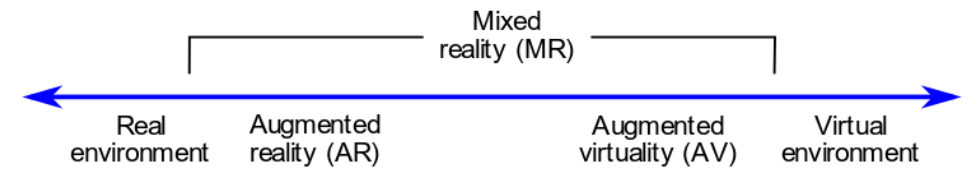
Figure 1. The continuum proposed by Milgram and Kishino [1] describing the interactions between reality and virtuality in creating augmented reality experiences. Reproduced without modifica- tion from Wikimedia Commons (source: https://commons.wikimedia.org/wiki/File:Virtuality_ continuum_2-en.svg, (accessed on 23 March 2022) licensed under: https://creativecommons.org/ licenses/by-sa/4.0/deed.en (accessed on accessed on 23 March